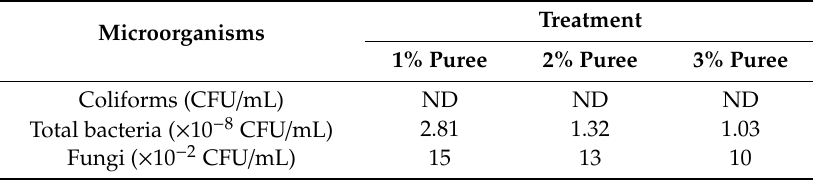
Table 8. Microbial population in yogurt during